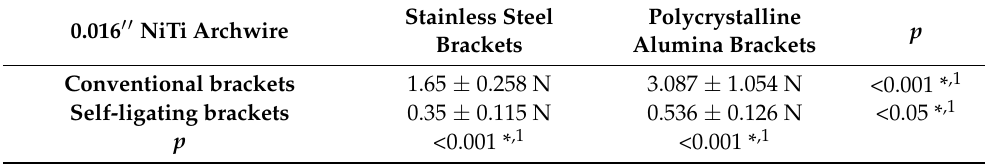
Table 2. Comparisonofstaticfrictionalforces(meanvalues)measuredforbracketswith0.016 (cid:48)(cid:48) NiTi